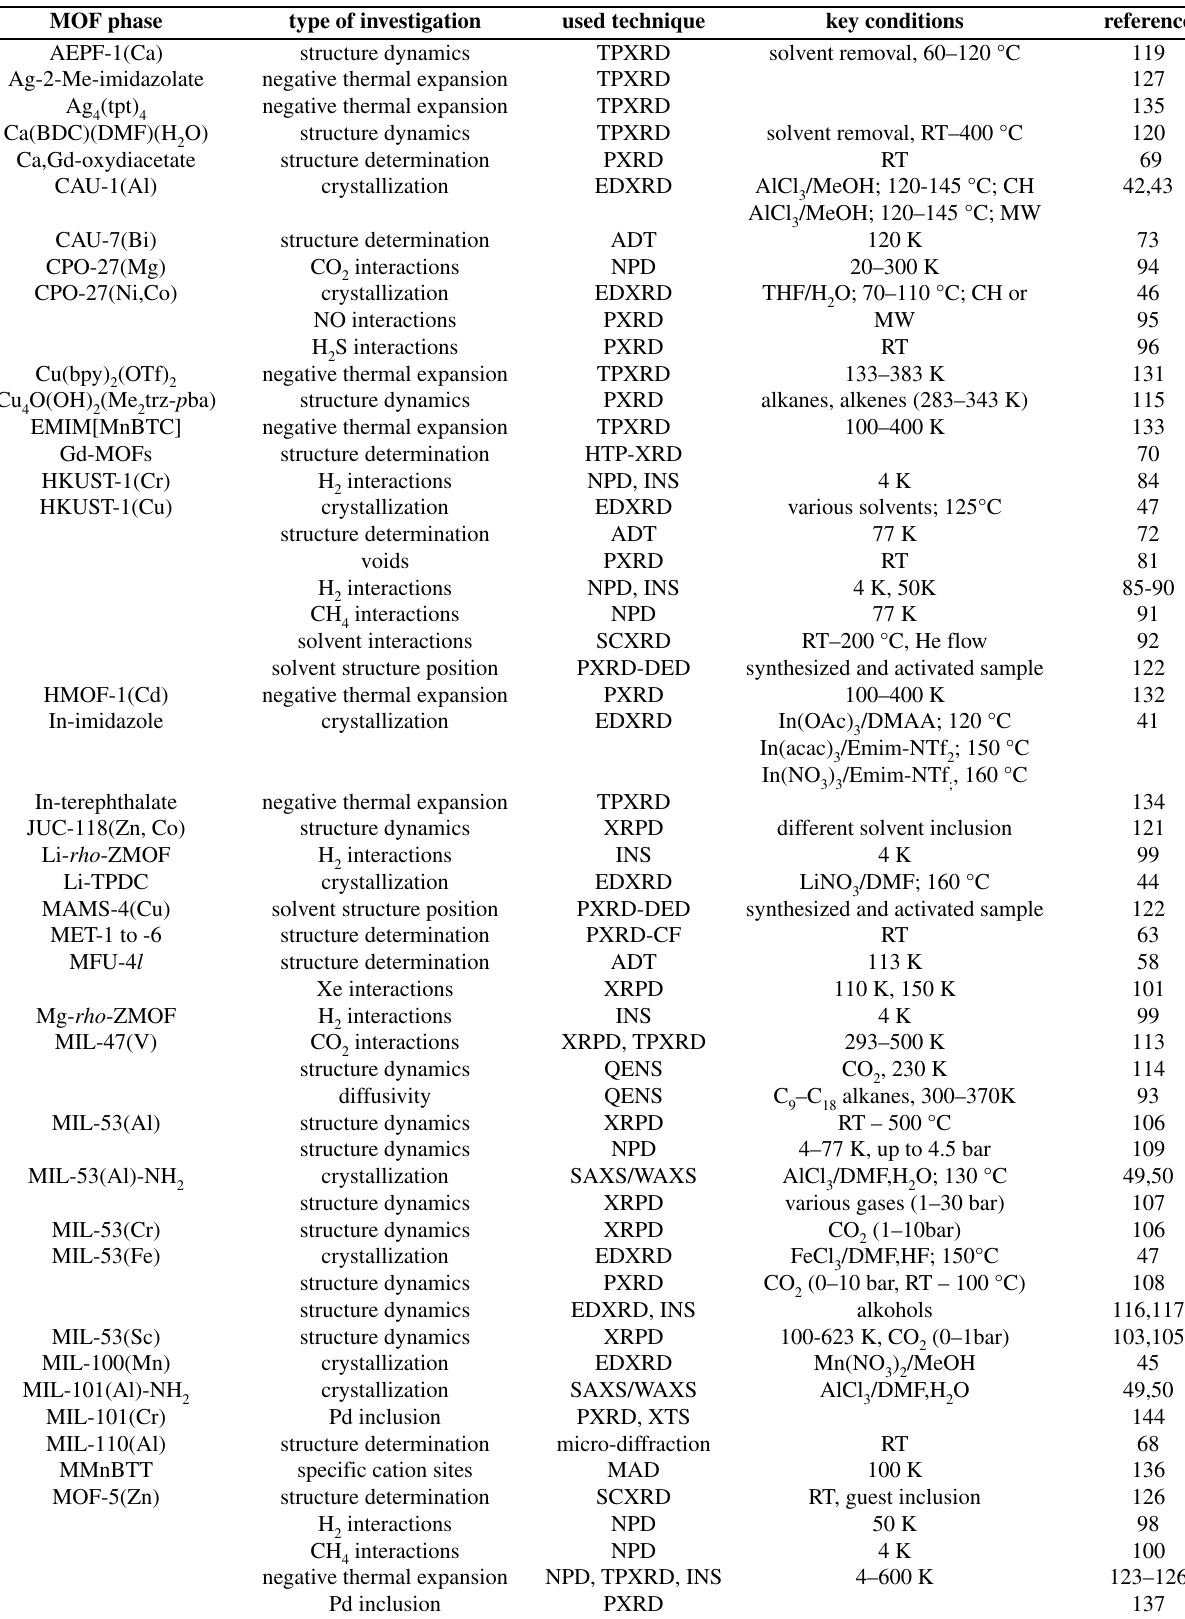
Table 1. Recent investigations on MOFs using diffraction and scattering